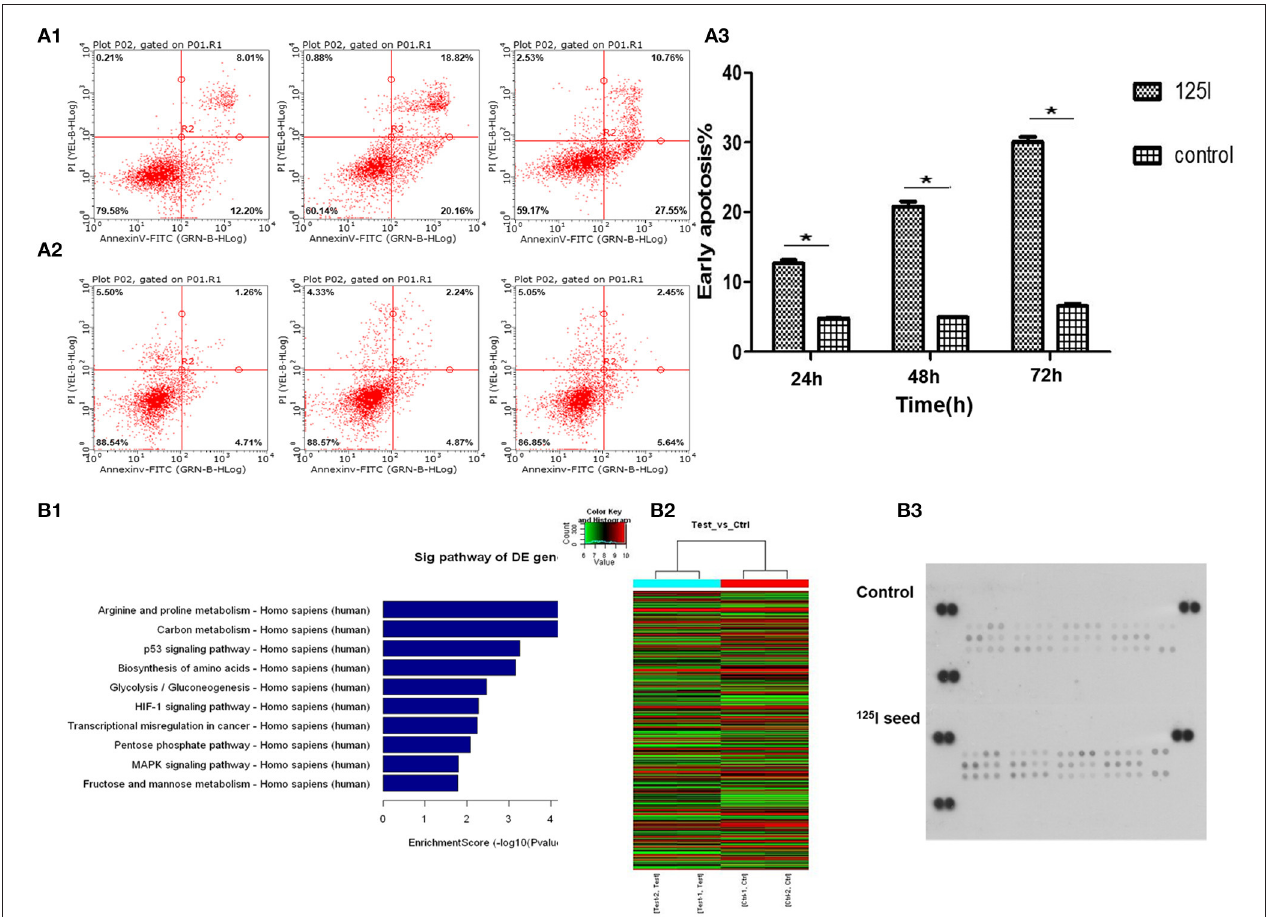
FIGURE 2 | Flow cytometric analysis indicates that the treatment of 125 I seed for different times induces early apoptosis in A549 cells. (A1) With the increase in irradiation time, the early apoptosis in the 125 I seed group increased gradually. (A2) The early apoptosis of control group cells had no obvious change. (A3) These data represent the means ± SD of three independent experiments. The difference between control and treated groups is statistically significant (* P < 0.05). The gene chip screened out 10 significant signal pathways (B1) . The results of the heat map of gene detection (B2) . Human phospho-MAPK array shows that 125 I seed activated (phosphorylated) MAPK family members Erk1/2, JNK (1–3), and p38 ( α / β / δ / γ ), and the Akt, GSK-3, p70 S6 kinase, TOR, p53, and CREB (B3) .